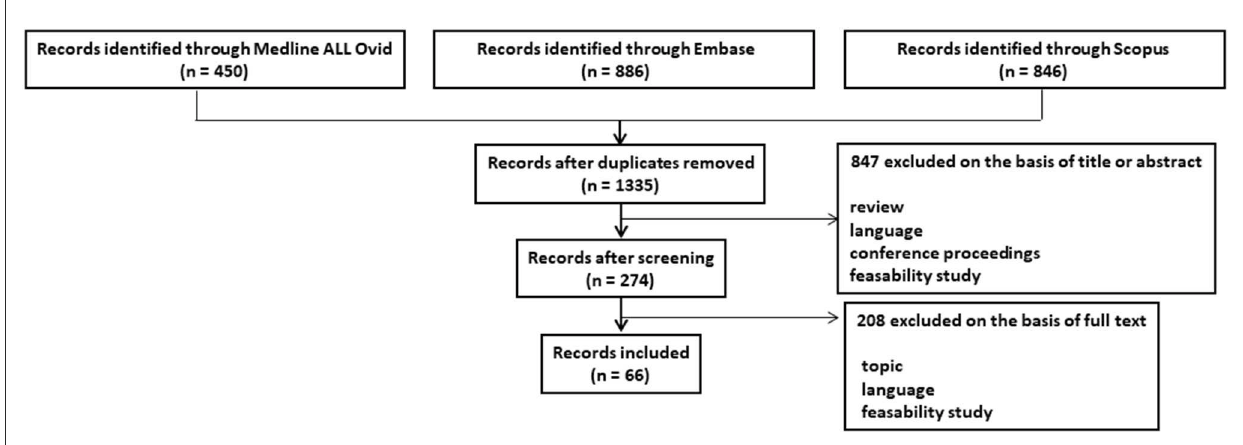
FIGURE1 PRISMA flowchart outlining study selection procedure.